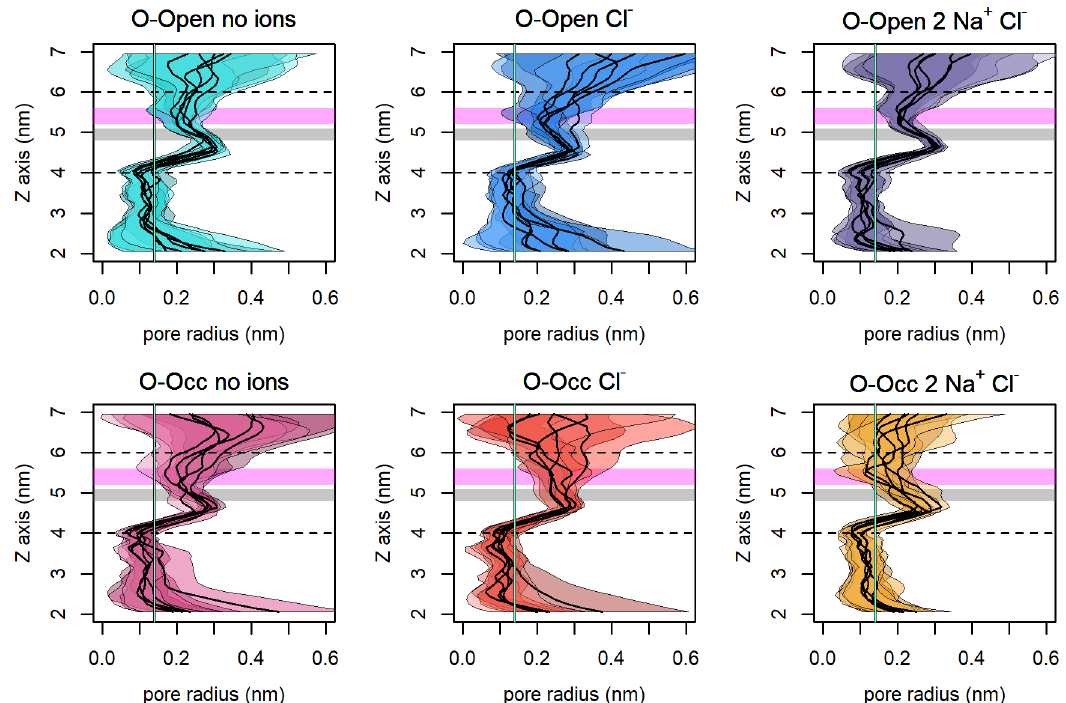
Figure 7. Mean pore radius ± standard deviation along the z -axis for every trajectory. The gray area indicates the extracellular hydrophobic lid, and the magenta area represents the extracellular salt bridge. The dashed lines show the bottom of the S1 binding pocket (at 4 nm) and the outer end of the extracellular vestibule (at 6 nm). The aquamarine vertical line indicates the radius of a water molecule (0.14 nm) for a comparison. The vestibule was considered closed if smaller than the size of a water molecule. Trajectories were analyzed every 1 ns.